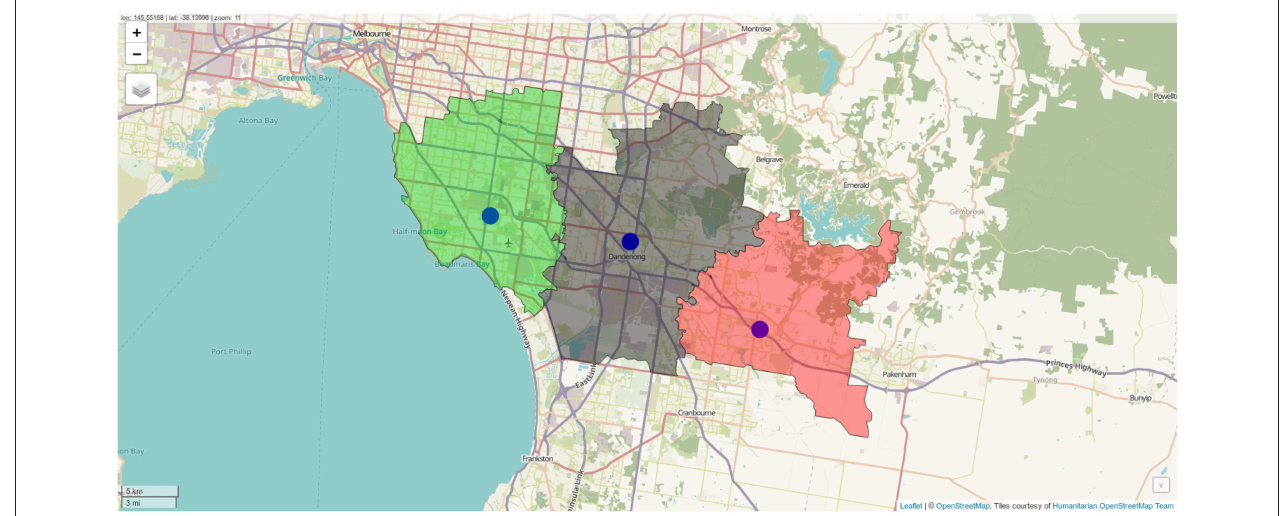
FIGURE 7 | Polygon representation of rehabilitation center catchment zones. Screenshot of interactive visualization created with mapview .